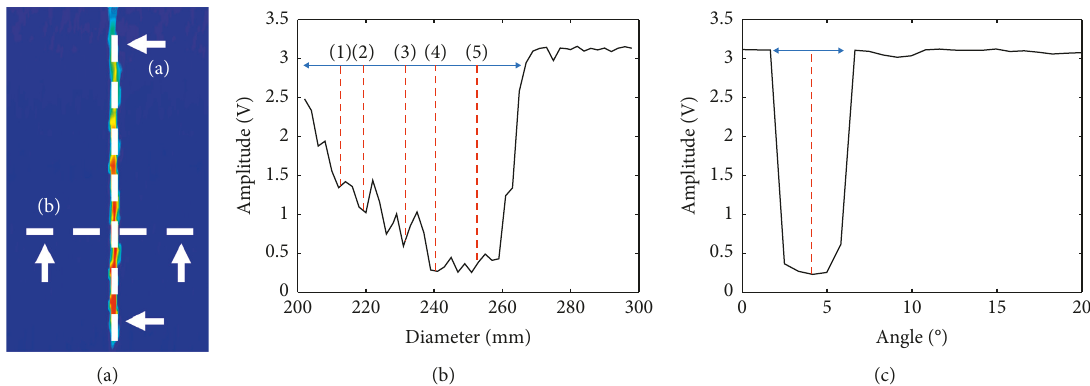
Figure 25: Inspection results for the C-2-1 crack: (a) C-scan and cross section amplitude of (b) radial direction and (c) circumferential direction.